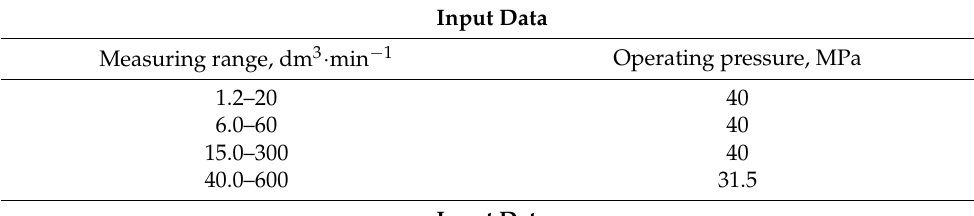
Table 3. Technical data of the sensor HYDAC EVS 3